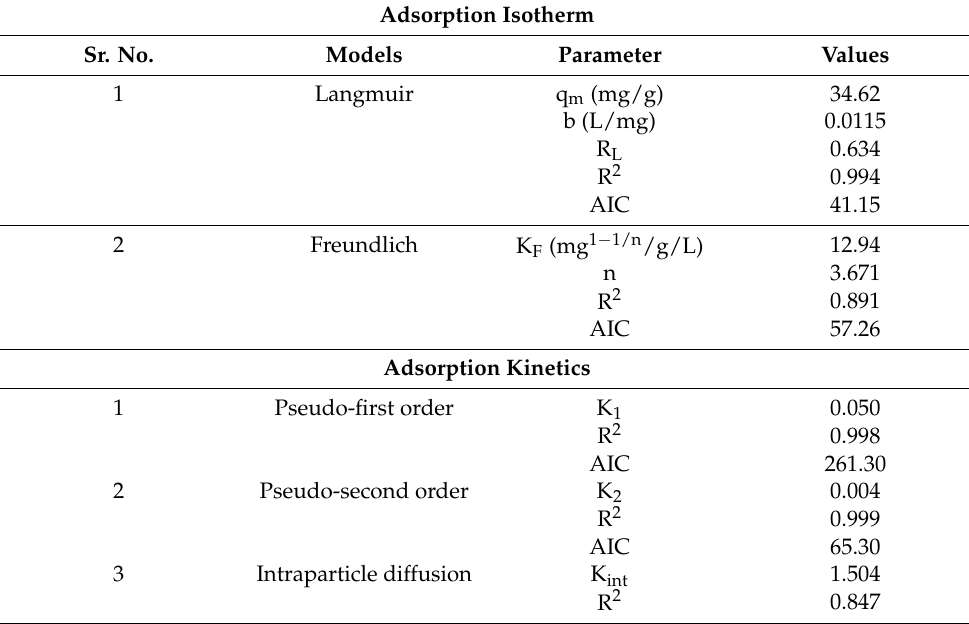
Table 1. Isotherm and kinetic parameters.